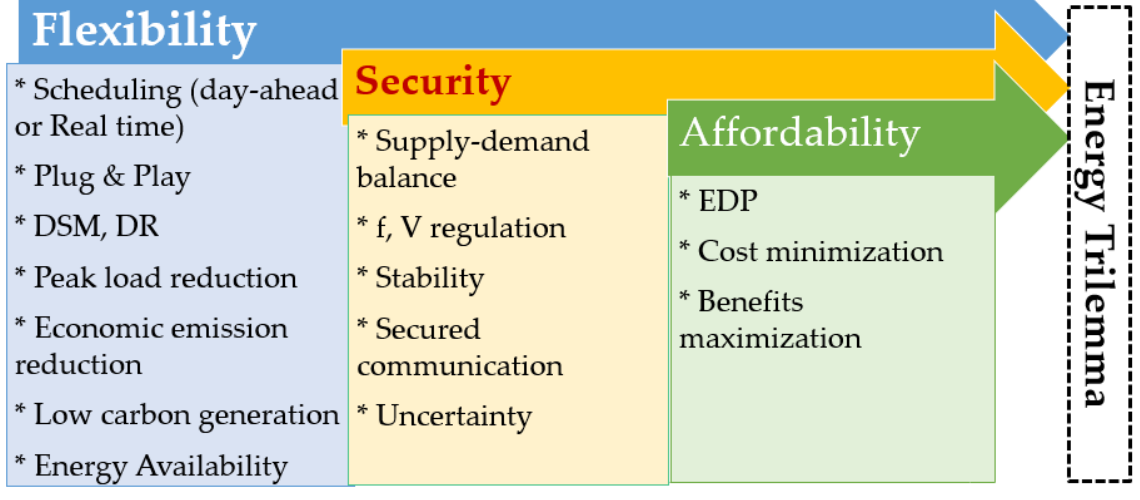
Figure 2. MG-EMS objectives and their relation to energy trilemma.